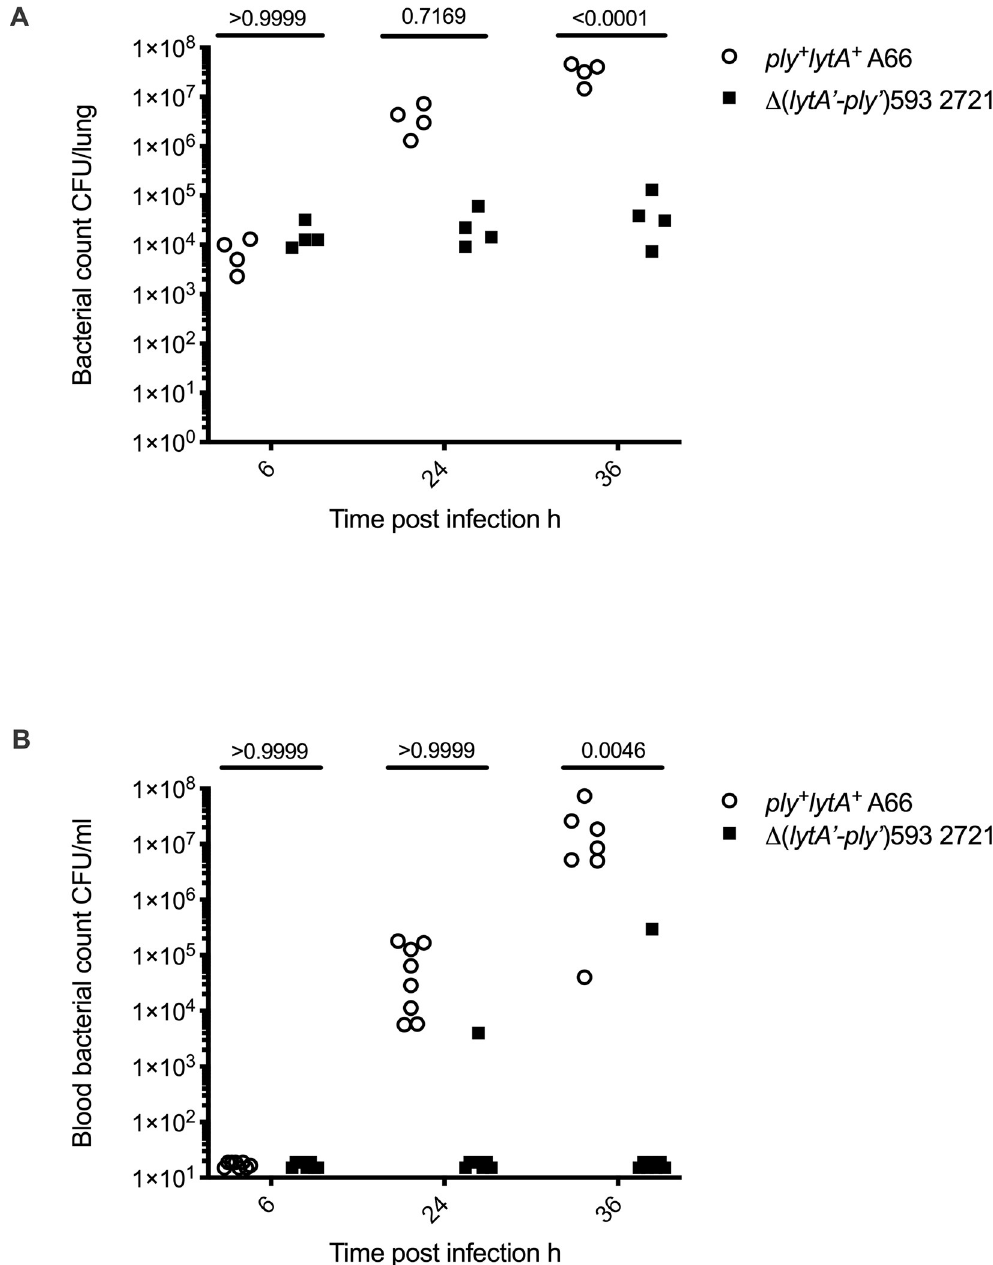
Fig 3. Δ ( lytA’-ply’ )593 strain 2721 persists in the lungs, but is unable to proliferate in this tissue or invade into the blood. Wild type C57Bl/6 mice were intranasally inoculated with 8 x 10 4 CFU of ply + lytA + strain A66 or 1.4 x 10 5 CFU of Δ ( lytA’-ply’ )593 strain 2721 and bacterial counts were determined in lung homogenates (A). Each symbol represents one animal, data were generated from a single experiment. Wild type C57Bl/6 mice were intranasally inoculated with 3–8 x 10 4 CFU of ply + lytA + strain A66 or 8–14 x 10 4 CFU of Δ ( lytA’-ply’ )593 strain 2721 and bacterial counts were determined in the blood (B). Each symbol represents one animal, 8 mice per group, data were pooled from two independent experiments. The lower limit of detection was 15 CFU/ml. Data analysed with two-way ANOVA followed by Sidak’s (A) or a Tukey’s (B) multiple comparison test. Adjusted P-values are reported.